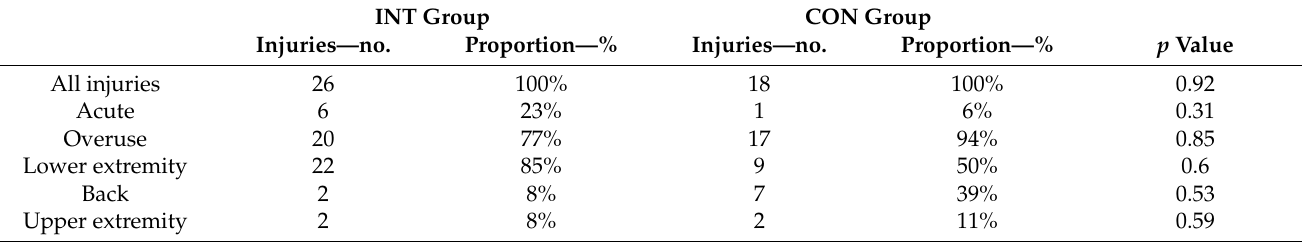
Table 3. Number of